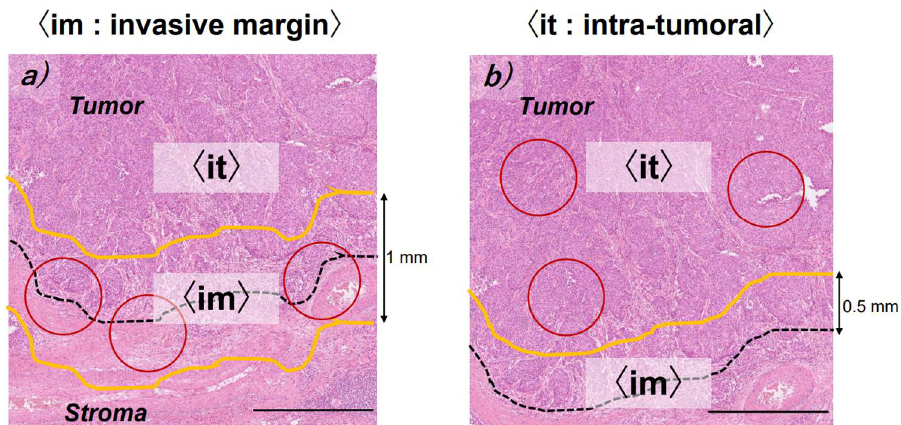
Figure 2. Representative examples of the evaluation of lymphocytes or macrophages testing positive for different markers. ( a ) Invasive margin area (the area centered on the border separating the tumor and normal stroma with an extent 1 mm), ( b ) intra-tumoral area (from the tumoral side to the invasive margin on the tumoral side) → The average value from three areas (circle of 0.75 mm 2 ) was calculated in each case. Bars: 1 mm.